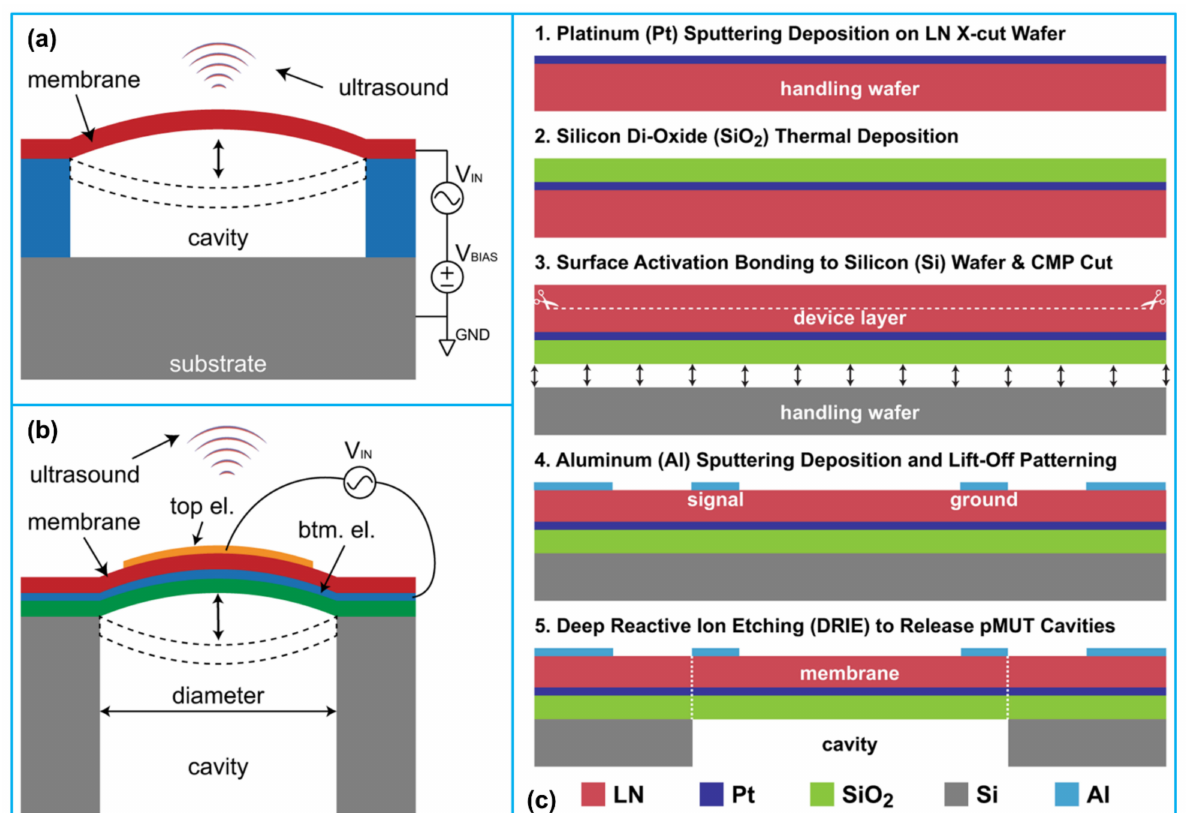
Figure 1. ( a ) Anatomy and working principle of a typical CMUT; ( b ) anatomy and working principle of a typical PMUT; ( c ) a typical fabrication process of a lithium niobate (LN) based PMUT. Reprinted from Ref. [26] with